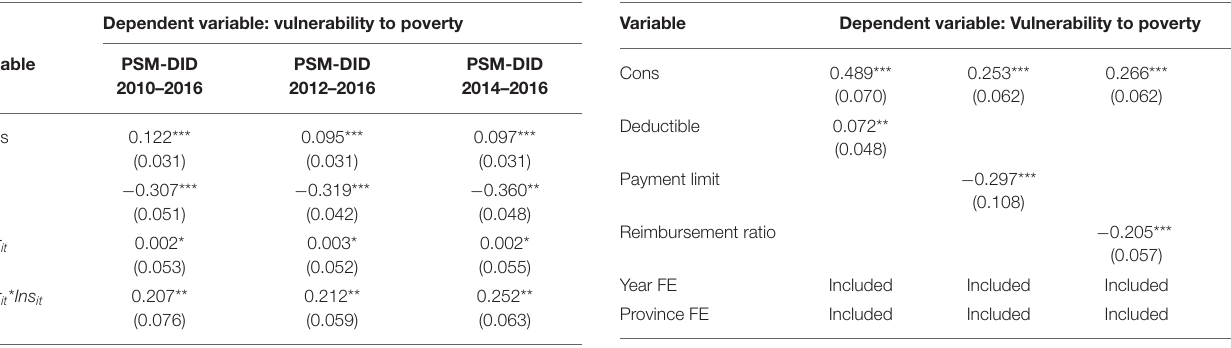
TABLE 4 | Difference in differences (PSM-DID) test. TABLE 5 | Effects on poverty